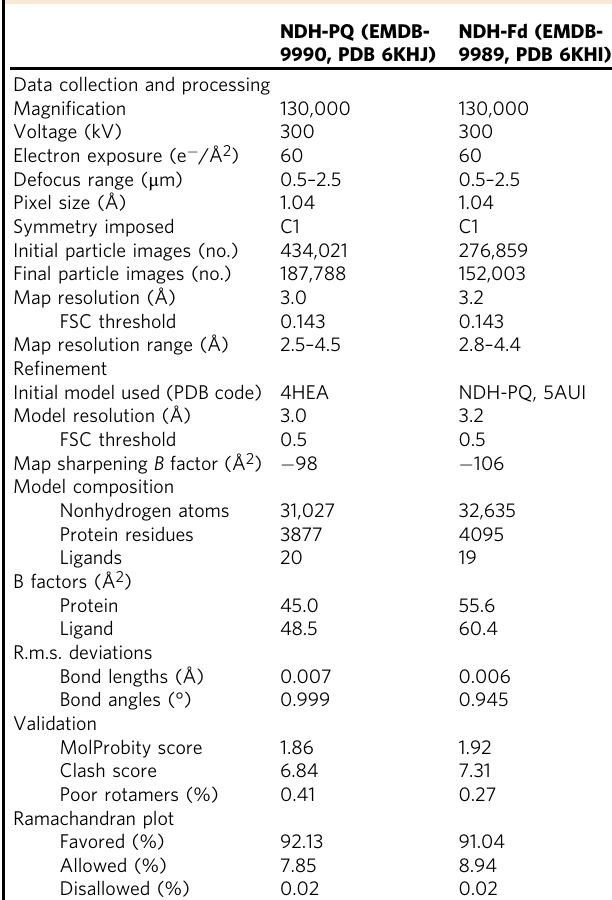
Table 1 Cryo-EM data collection and re fi nement and validation